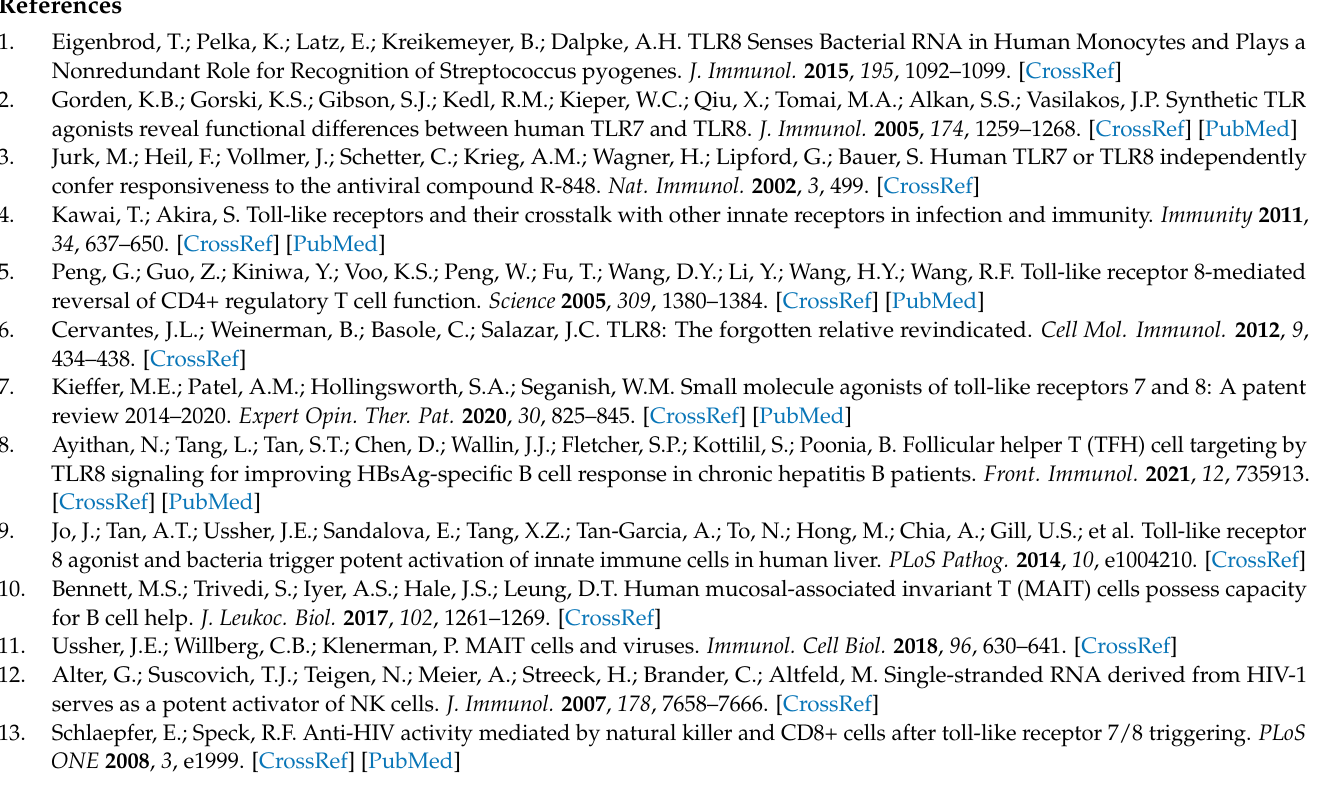
SLGN treatment in healthy subjects, Figure S3: Protein-protein interaction networks, Table S1: List of flow cytometry antibodies, Table S2: List of genes deregulated in monocytes with 8 h Selgantolimod treatment and Table S3: List of genes deregulated in lymphocytes with 8 h Selgantolimod